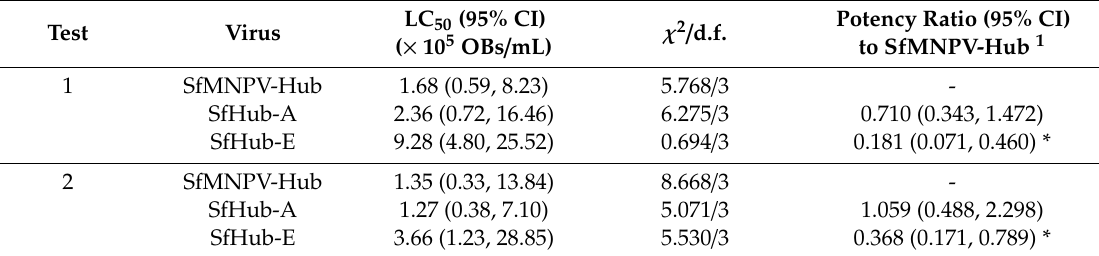
Table 1. Median lethal concentrations (LC 50 ) of SfMNPV field isolate and genotypes against second ‐ instar Spodoptera frugiperda larvae.